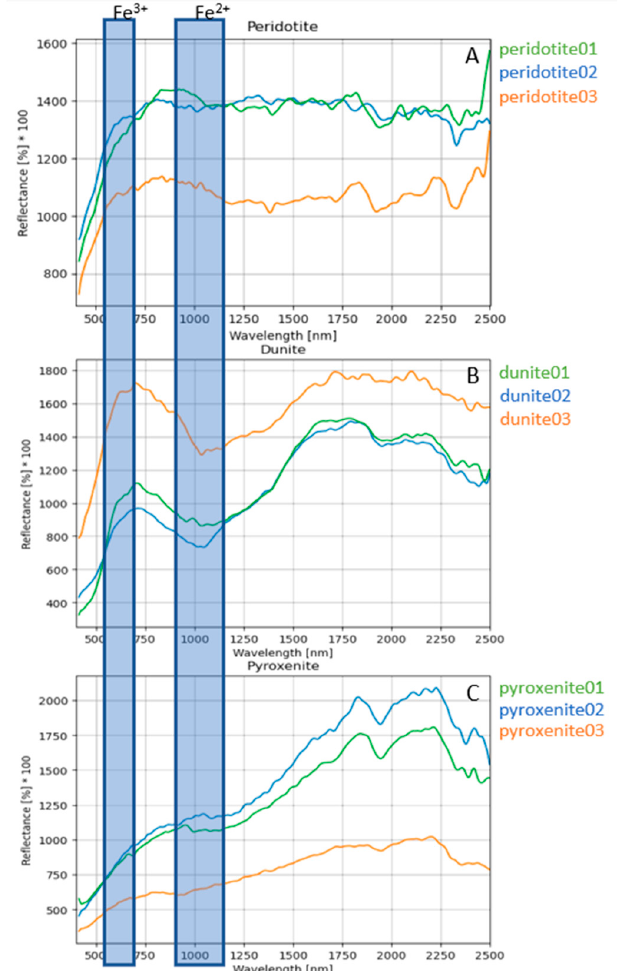
Figure 3. Laboratory examples of spectral signatures in the spectral range of 400 to 2500 nm of ( A ) peridotite (olivine 40–90%), ( B ) dunite (olivine > 90%), and ( C ) pyroxenite (olivine < 40%) of collected rock samples from the Niaqornarssuit Complex. The measurements were conducted on the weathered surfaces of the rock samples from the study site (Figure 1). Blue rectangles represent the spectral range of absorption features from ferrous (Fe 2+ ) and ferric (Fe 3+ ) iron.